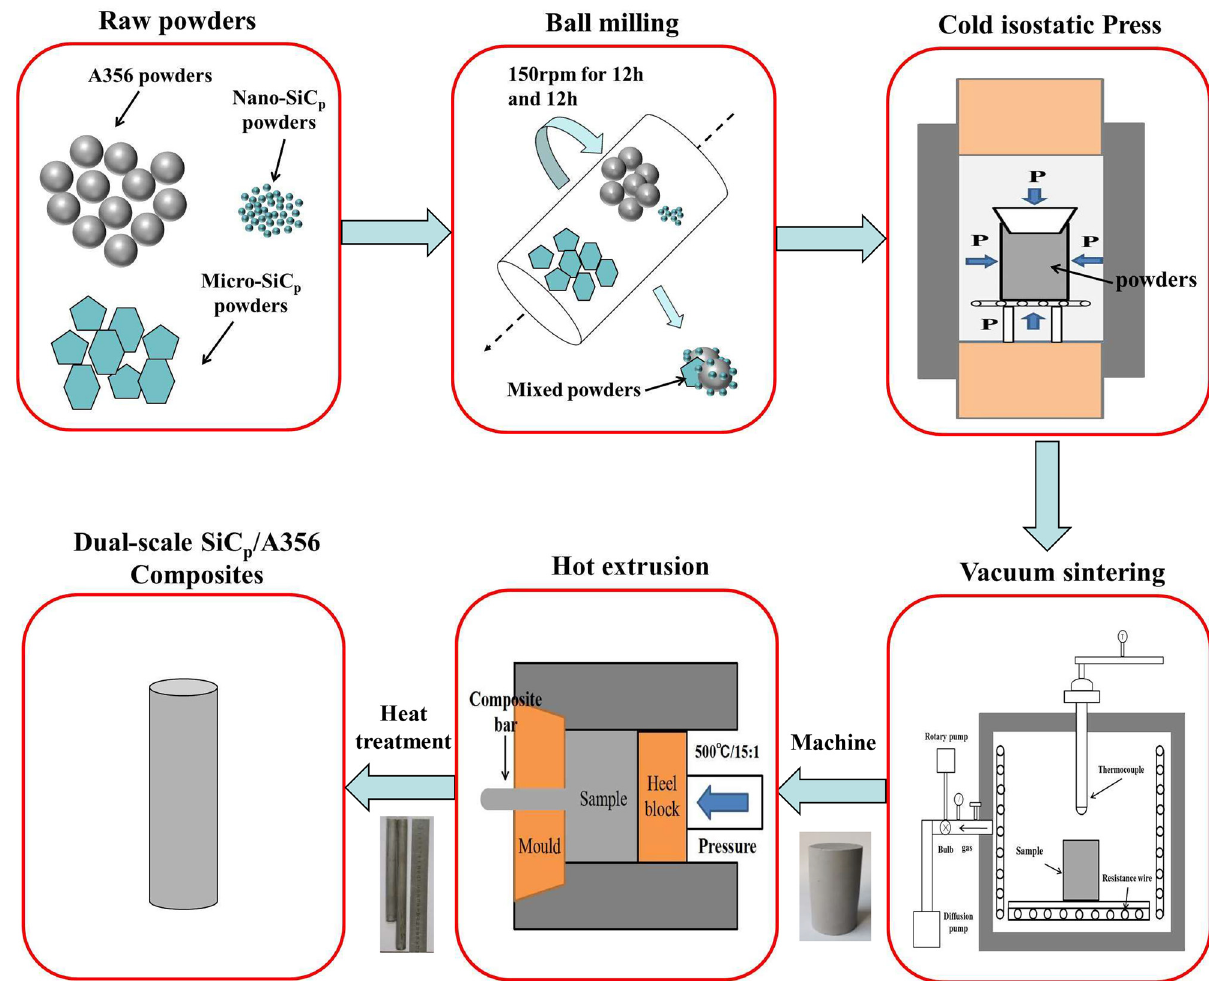
Figure 1: The fabrication process of dual - scale SiC p /A356 composites